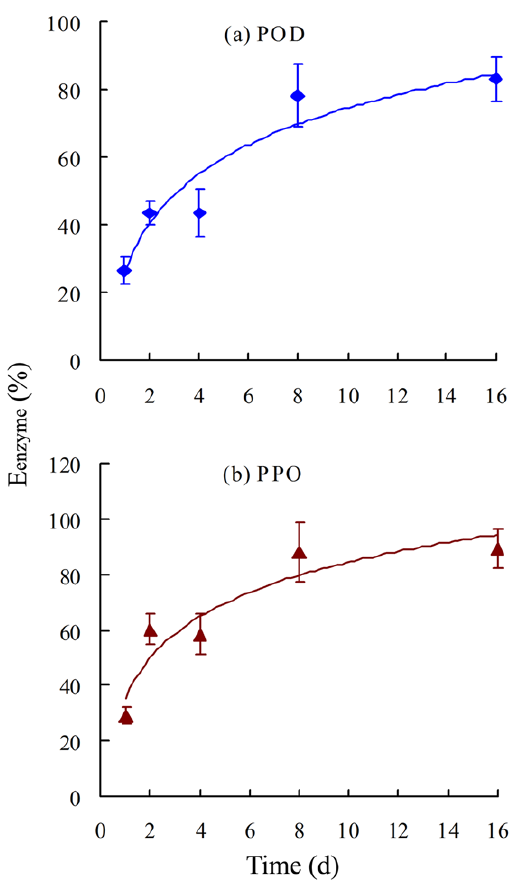
Figure 3. Inhibition efficiency ( E enzyme , % ) of ascorbic acid on ( a ) POD and ( b ) PPO activities in plant roots. E enzyme was calculated as: E enzyme = (U c –U AA )/U c 6 100%, where U AA and U c represent the enzyme activities in roots grown in the presence and absence of AA, respectively. Error bars represent standard deviations